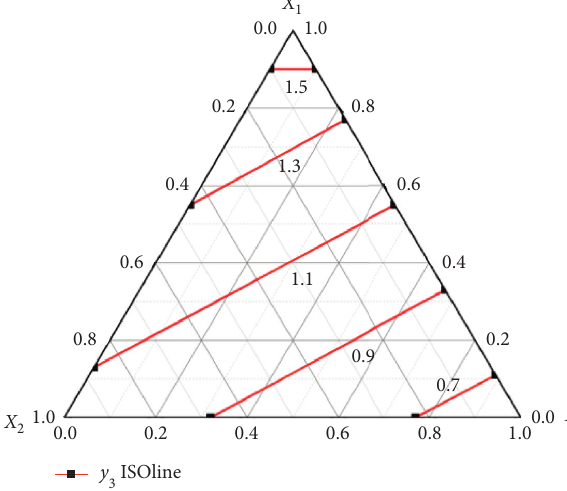
Figure 6: Isogram of standard deviation y